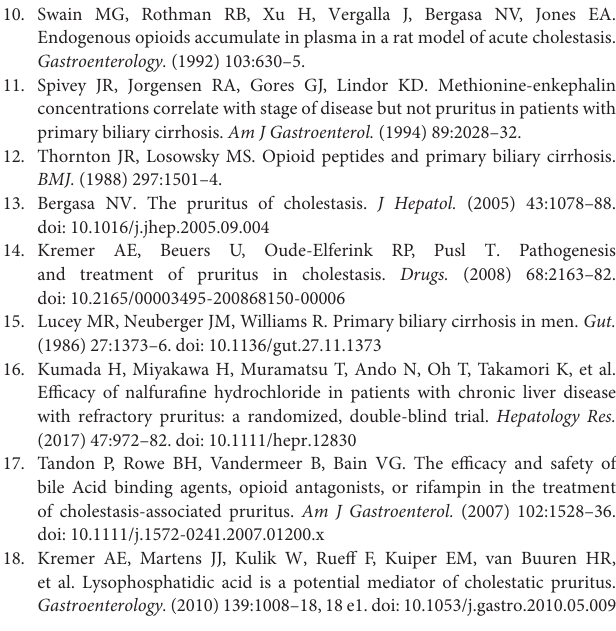
Supplementary Figure 1 | No correlation of cholestatic parameters with itch intensity of patients with cholestatic liver diseases. The cholestatic parameters γ GT (A) , AP (B) , and total serum bilirubin (C) did not correlate with the reported itch intensity assessed as the mean itch VAS score over the last week. Correlations were statistically calculated using Spearman’s rank. Supplementary Figure 2 | No correlation of cholestatic parameters with endogenous opioid levels in patients with cholestatic liver diseases. Levels of all tested endogenous opioids were correlated with laboratory cholestasis markers γ GT, AP, and total serum bilirubin of all included patients with cholestatic liver diseases (n = 56). No correlation between any opioid concentration and and cholestasis parameter was observed. Correlations were statistically calculated using Spearman’s